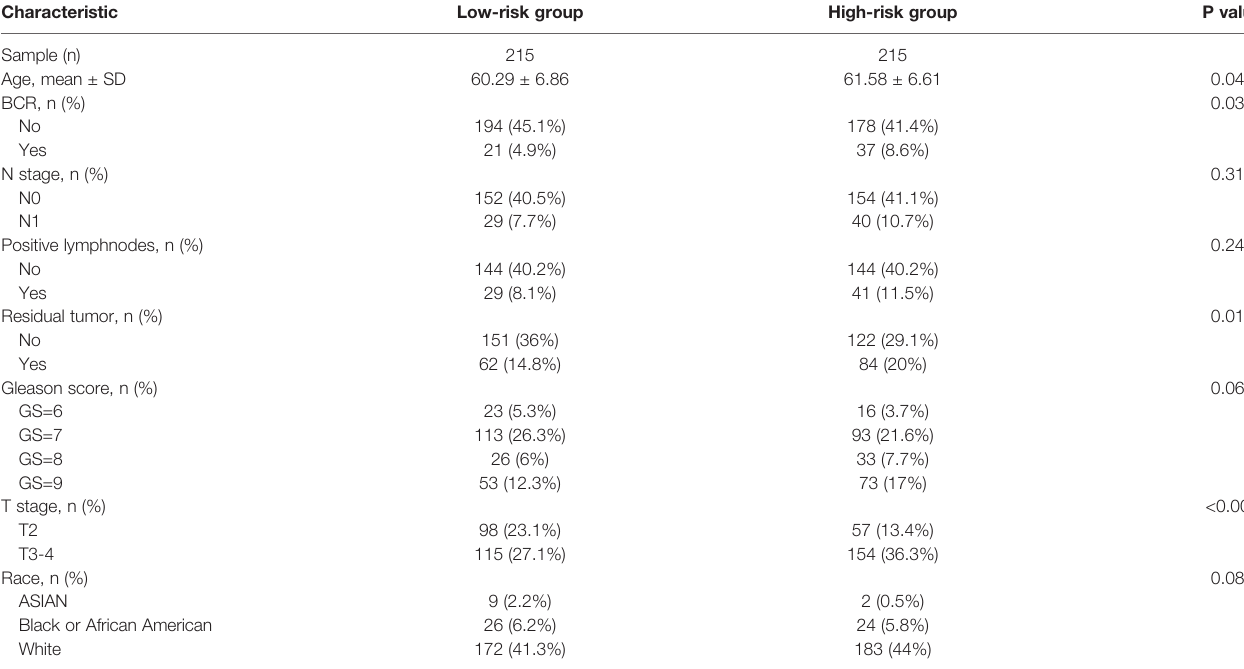
TABLE 1 | The correlations between EMGPI and clinical parameters in the TCGA database.